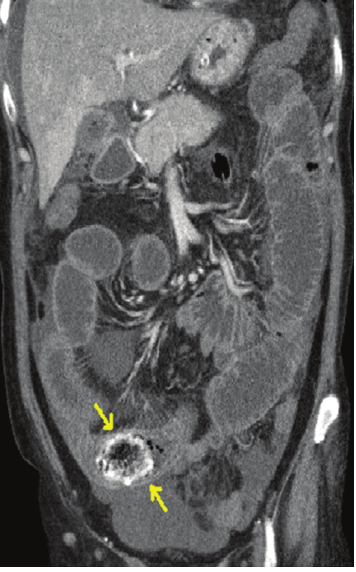
Figure 1: Obstructive lesion in terminal ileum and proximal dila- tation on abdominal CT.